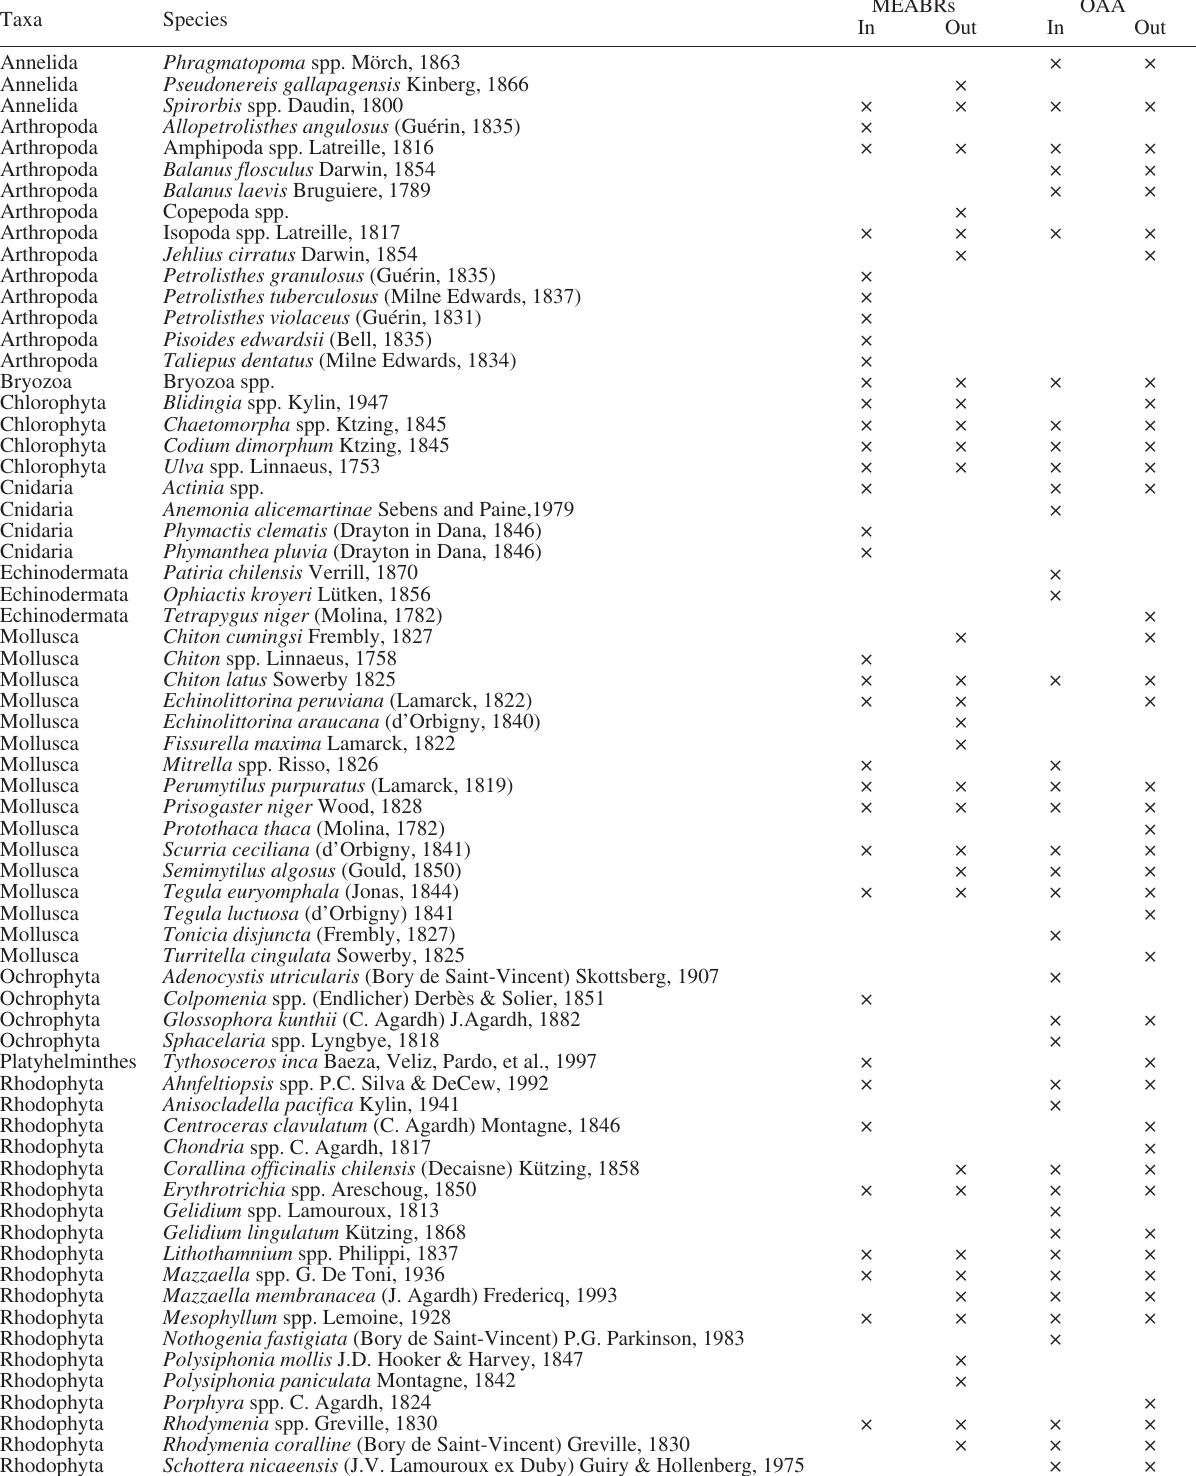
Table 1. – Taxonomic list of species found in each sampling zone, inside and outside exclusion cages. MEABRs, Management and Exploita- tion Area for Benthic Resources; OAA, Open-Access Area; IN, inside exclusion cages; and OUT, outside exclusion cages.